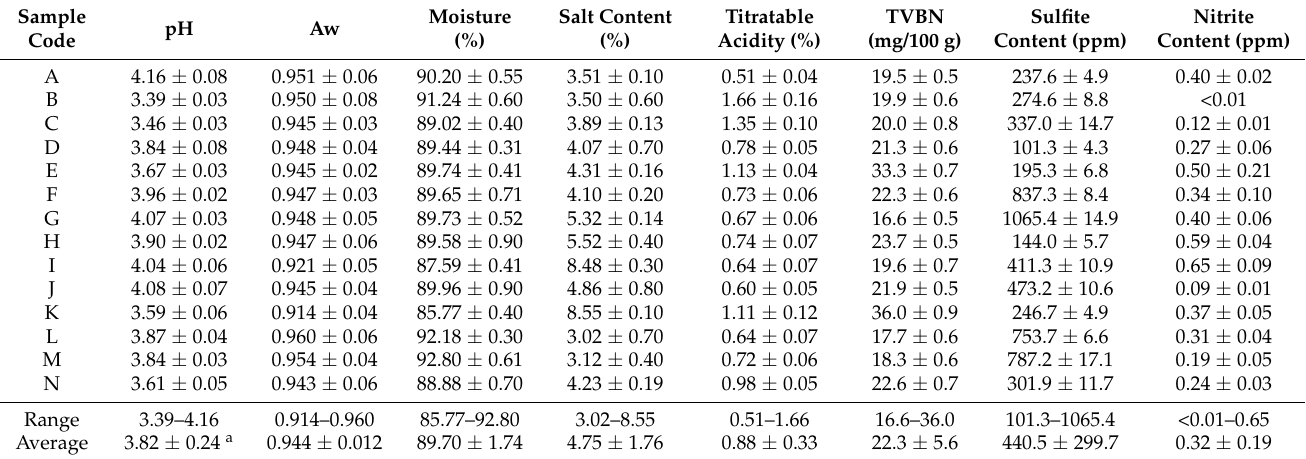
Table 2. pH, water activity (Aw), moisture, salt content, titratable acidity, total volatile basic nitrogen (TVBN), sulfite content, and nitrite content in mustard pickle products from retail market.